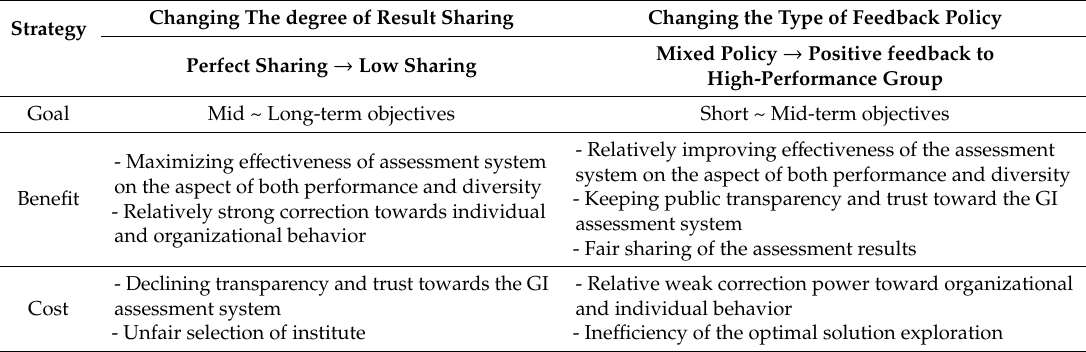
Table 9. Comparison between di ff erent improvement strategy of the GI assessment